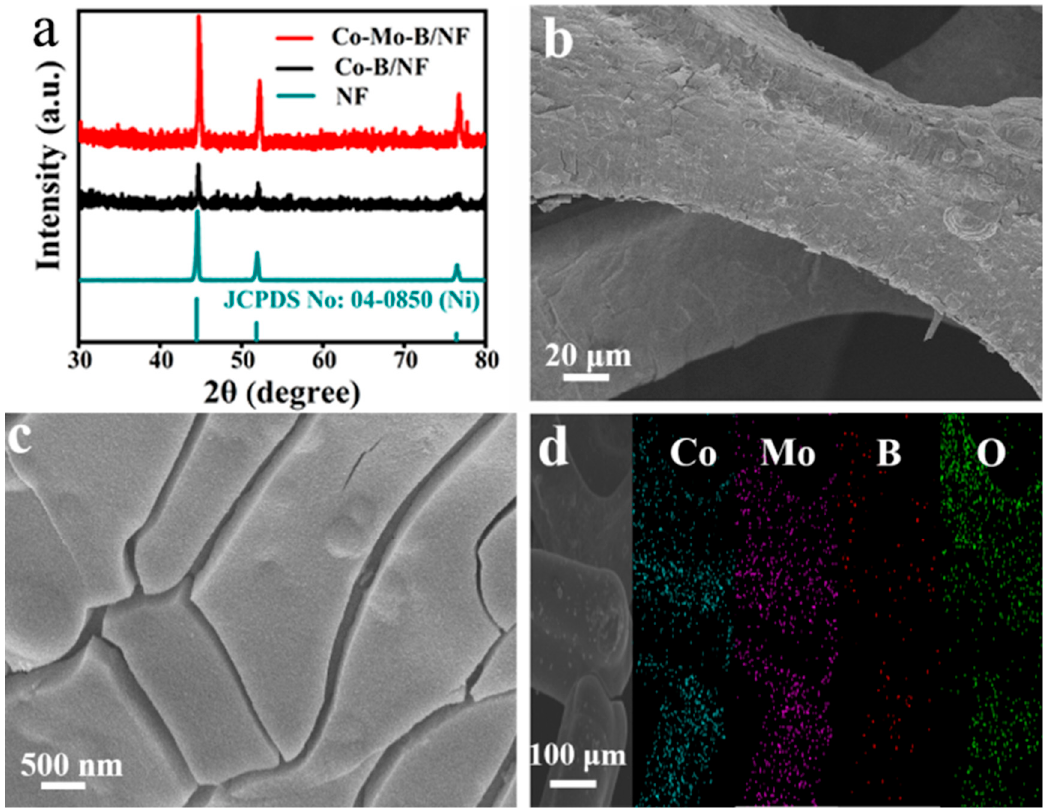
Figure 1. ( a ) XRD patterns of Co-Mo-B/NF, Co-B/NF, and NF. ( b ) Low- and ( c ) high-magnification SEM images of Co-Mo-B/NF. ( d ) SEM image and corresponding EDX elemental mapping images of Co-Mo-B/NF.